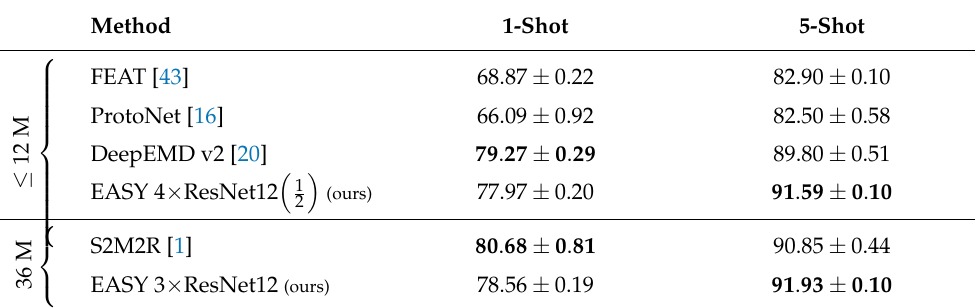
Table 4. The 1-shot and 5-shot accuracy of state-of-the-art methods and the proposed solution on CUB-FS in the inductive